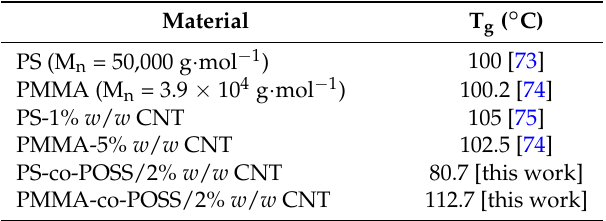
Table 2. The effect of nanofillers on nanocomposite glass temperature transitions T g .